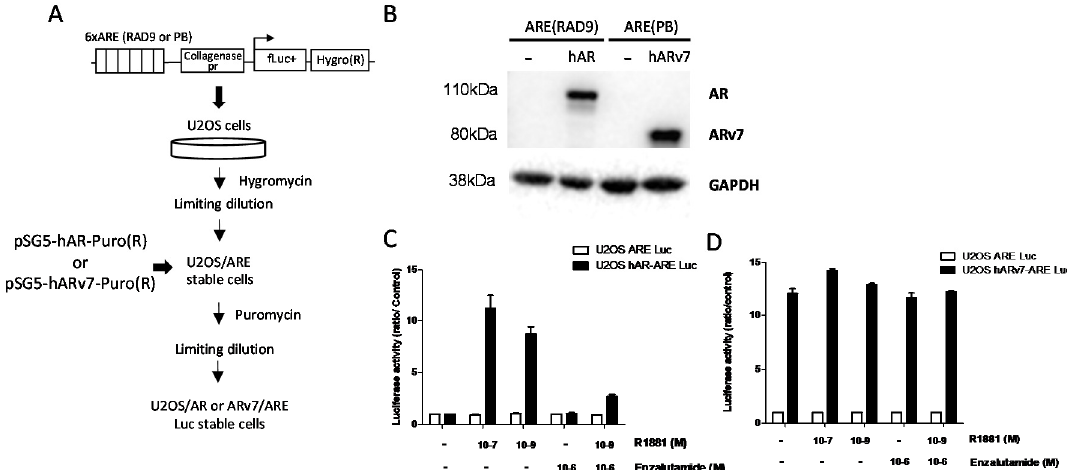
Figure 1. The U2OS osteosarcoma cell models used for this study. ( A ) Workflow of the generation of U2OS cells stably expressing full-length AR or ARv7. Cells were transfected with the firefly luciferase (fLuc + ) reporter plasmid, under the control of androgen responsive element carrying a hygromycin resistance marker, and stable clones were selected by limiting dilutions. Then, cells were transfected with a plasmid encoding the androgen receptor (AR), or ARv7 carrying a puromycin resistance marker, and stable clones were selected by limiting dilutions. ( B ) Representative immunoblots ( n = 3) of full-length AR or ARv7 in U2OS-hAR-ARE-Luc, U2OS-hARv7-ARE-Luc, and U2OS-ARE-Luc control cells. GAPDH was used as a loading control. ( C , D ) Modulation of full-length AR and ARv7 transcriptional activity by R1881 and enzalutamide, as evaluated by luciferase activity. Results of 3 independent experiments (± SEM) are expressed as fold change as compared to controls set at 1.